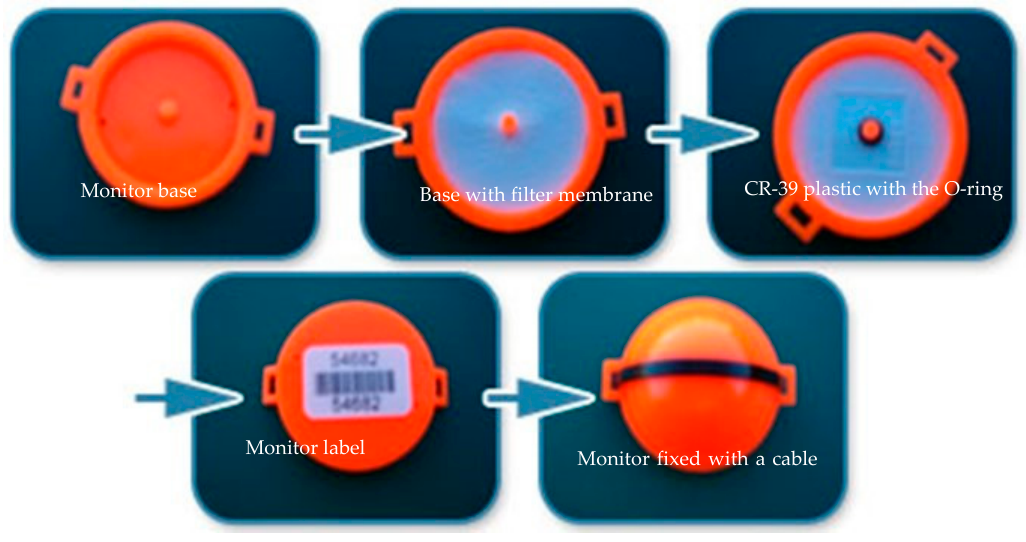
Figure 3. Radon gas monitor (RGM S )